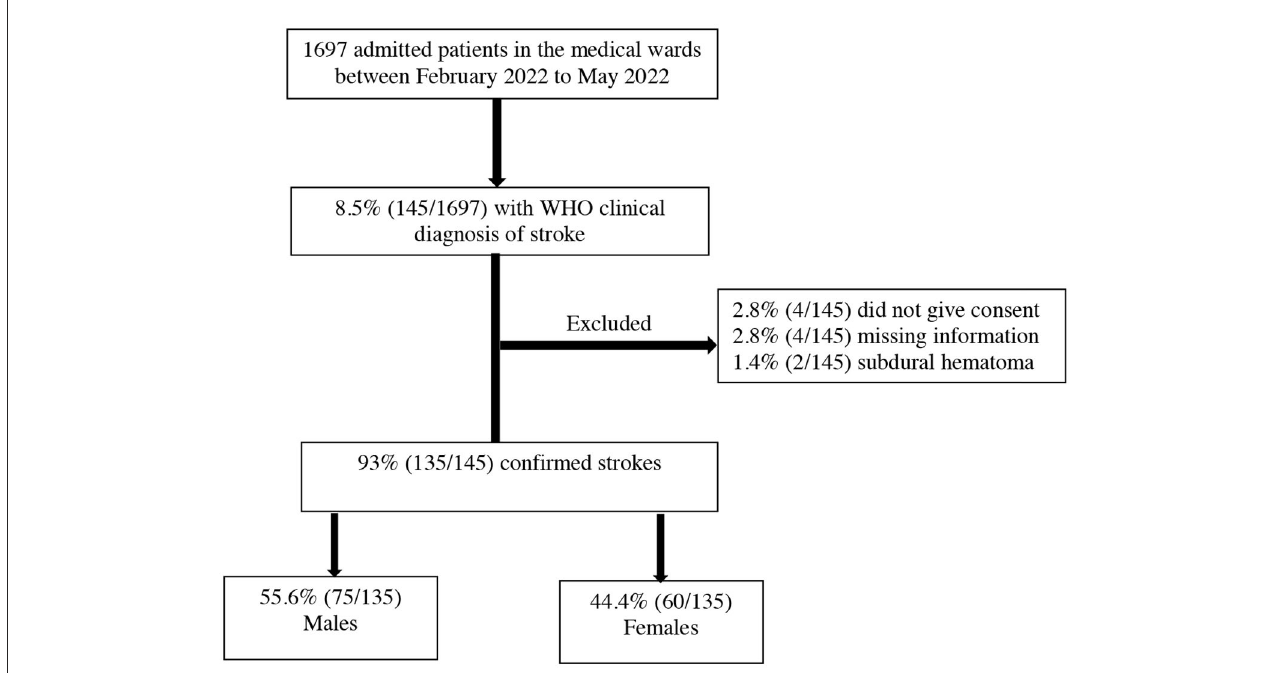
FIGURE1 Recruitment